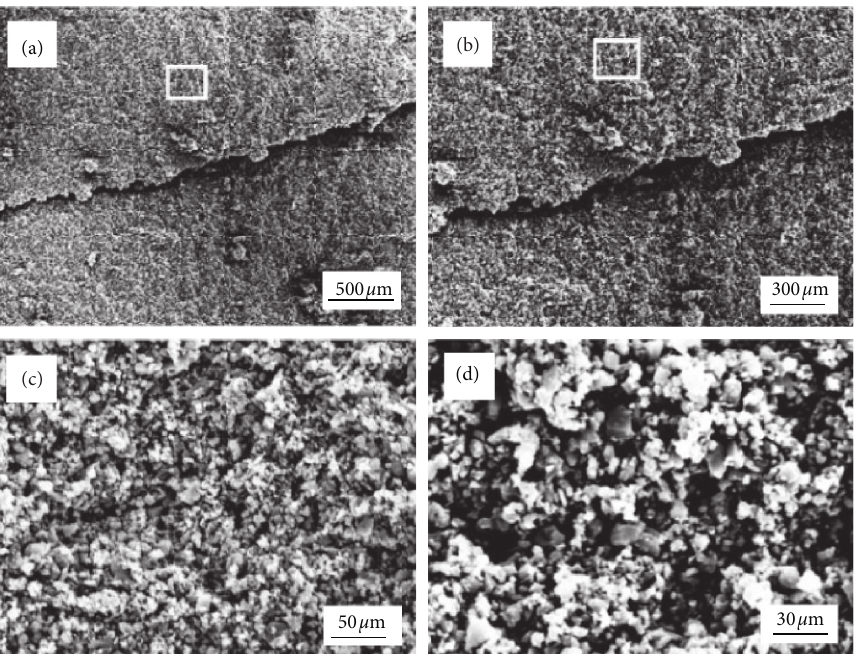
Figure 4: SEM images of the molar ratio of Si/B � 1 :1 sample with different magnification time: (a) 150; (b) 300; (c) 500; (d) 1500..